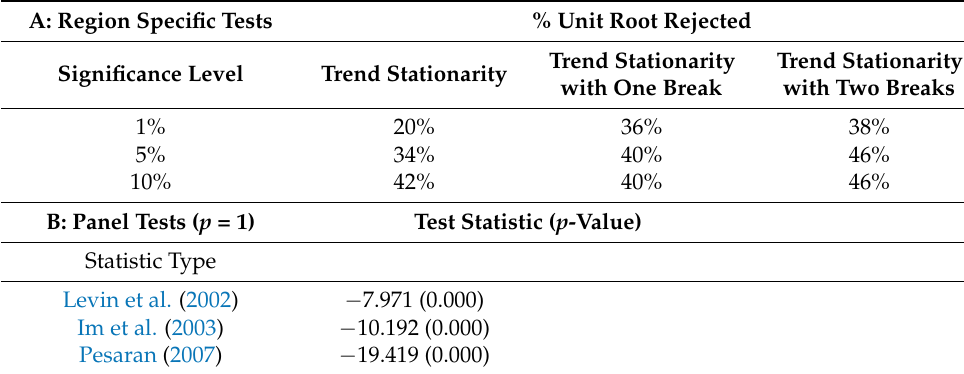
Table 2. Results of unit root tests on foreclosure